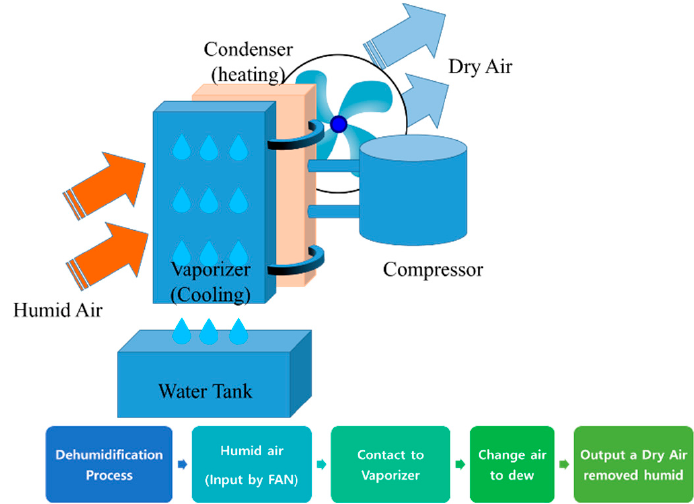
Figure 1. Principle of the dehumidifier.